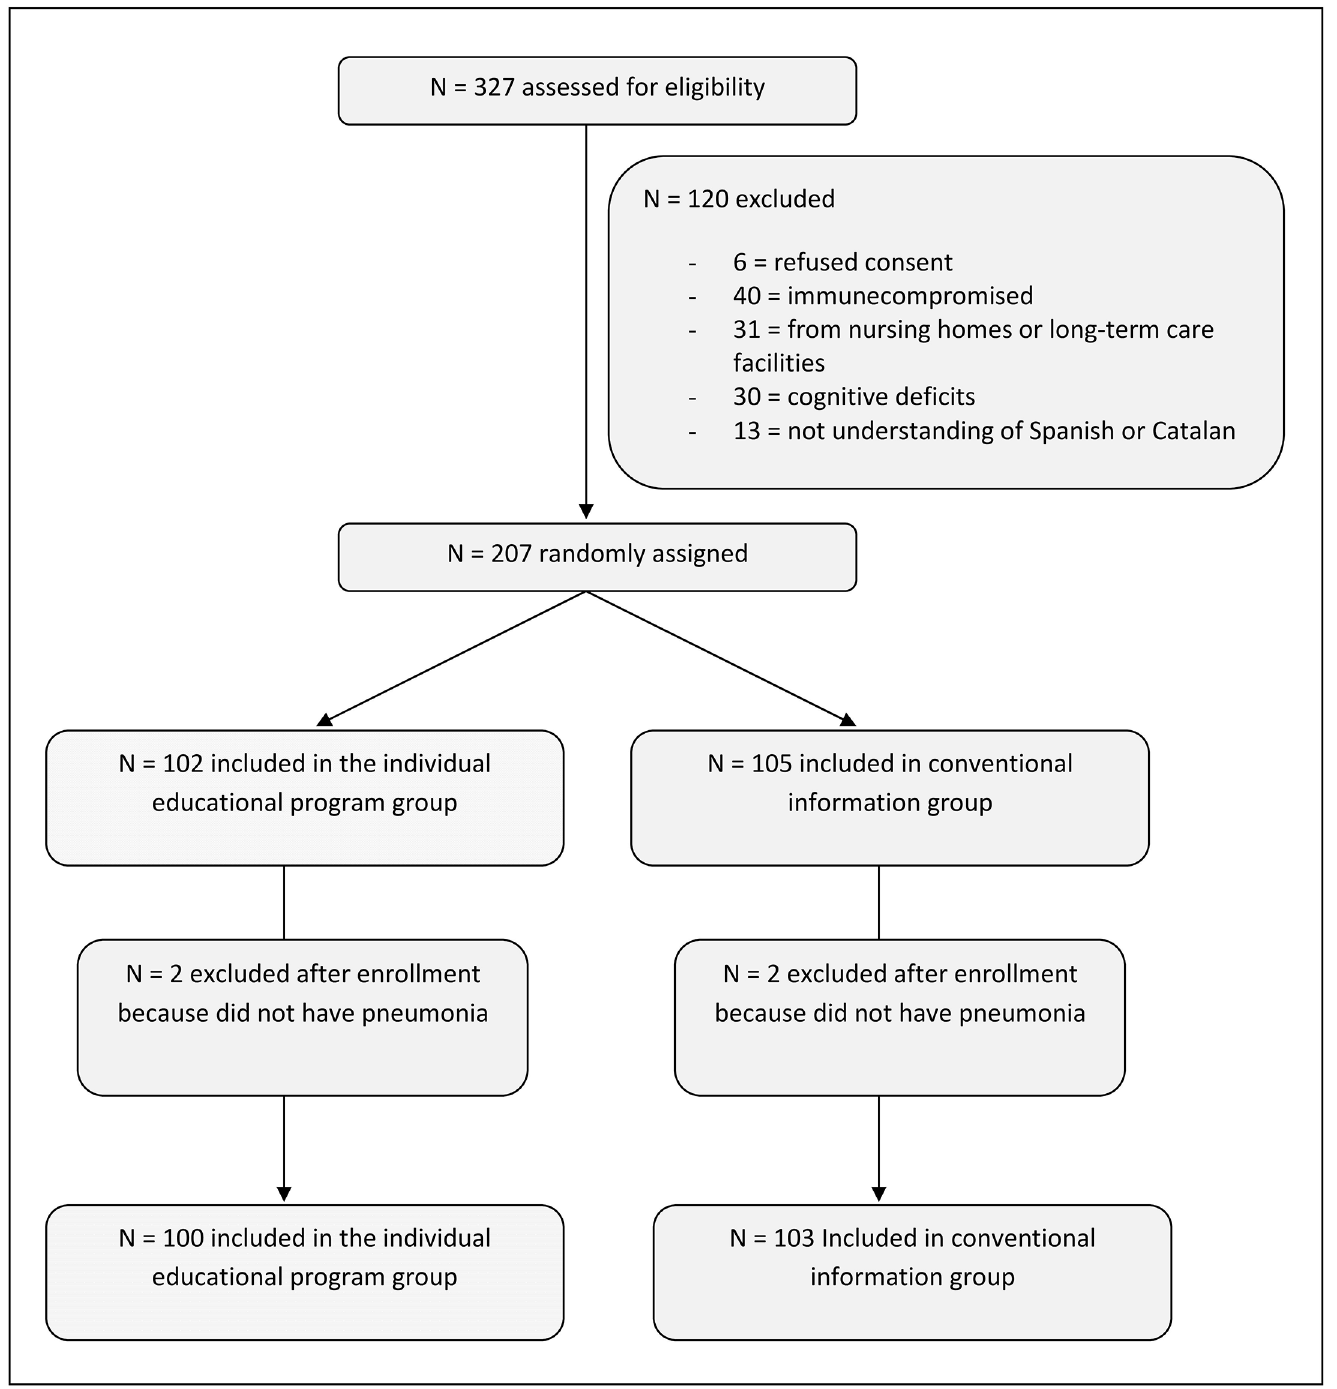
Fig 1. Flowchart of the